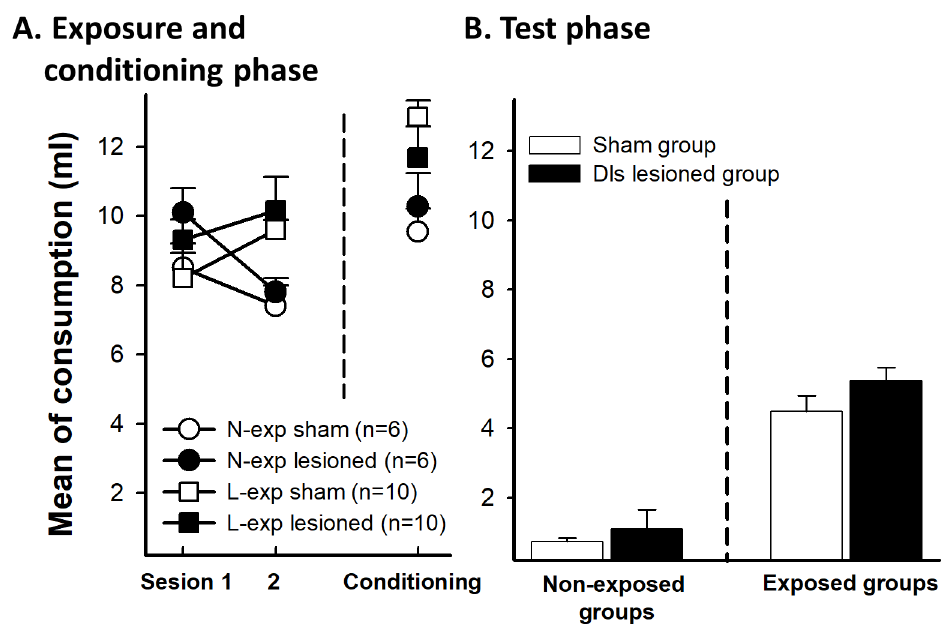
Fig 4. A. (left) Mean saccharinintake (ml) duringthe two sessions of preexposureand (right) conditioning phasefor sham and dls lesionedanimals(L-exp and N-exp). The graph shows the consumption for preexposed and non-preexposed groups to the future CS. L-exp groups was exposedto saccharinetwo days before conditioning and N-exp groups were similar to experiment 1A. B. Test phase. Effects of dls lesion on mean saccharinintake in limited exposureof the future CS (L-exp). Error bars representSEMs. N-exp: non exposedgroups, L-exp: limited exposure